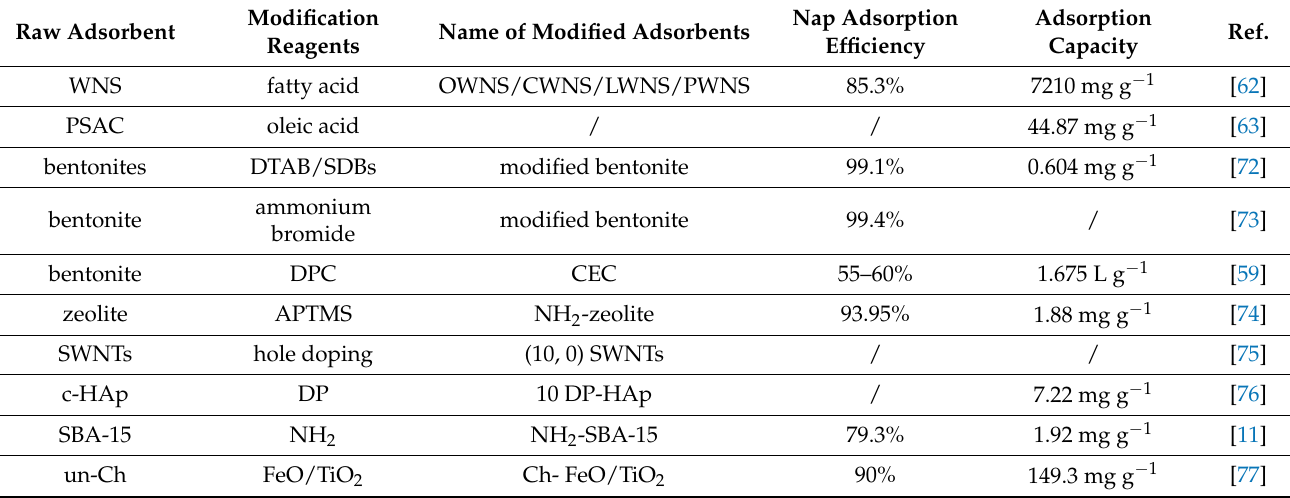
Table 4. Summary of the modification reagents, the name of the raw and modified adsorbents, the adsorption efficiency of Nap, and the maximum adsorption capacity of modified